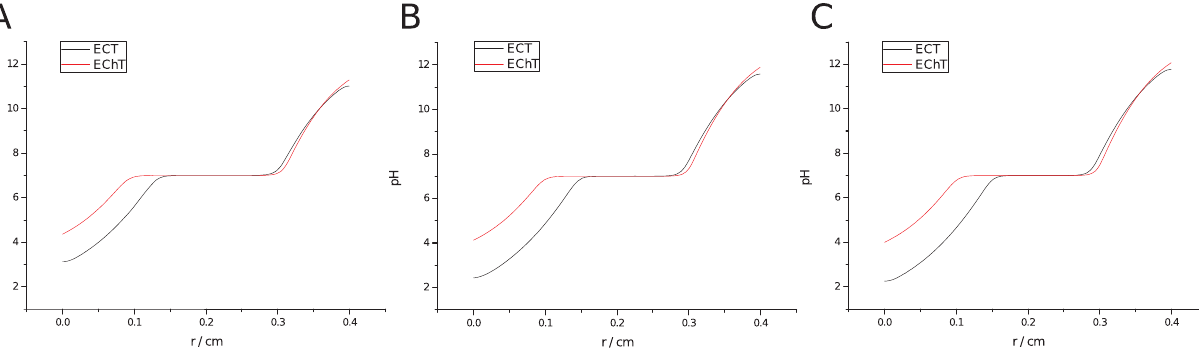
Figure 6. Predicted pH variation during ECT (black) and EChT(red), with same electric current dosage. Anode at left and cathode at right: a) 34 C = m 2 , ECT: 8 pulses of 100 V and 100 m s at 1 Hz , 4 : 2 : 10 4 A = m 2 and 8 s total, EChT: 4 : 2 A = m 2 , 8 s ; b) 135 C = m 2 , ECT (8 pulses of 400 V and 100 m s at 1 Hz , 1 : 7 : 10 4 A = m 2 and 8 s total), EChT ( 17 A = m 2 , 8 s ); c) 204 C = m 2 , ECT (8 pulses of 600 V and 100 m s at 1 Hz , 2 : 5 : 10 4 A = m 2 and 8 s total), EChT ( 25 : 4 A = m 2 , 8 s